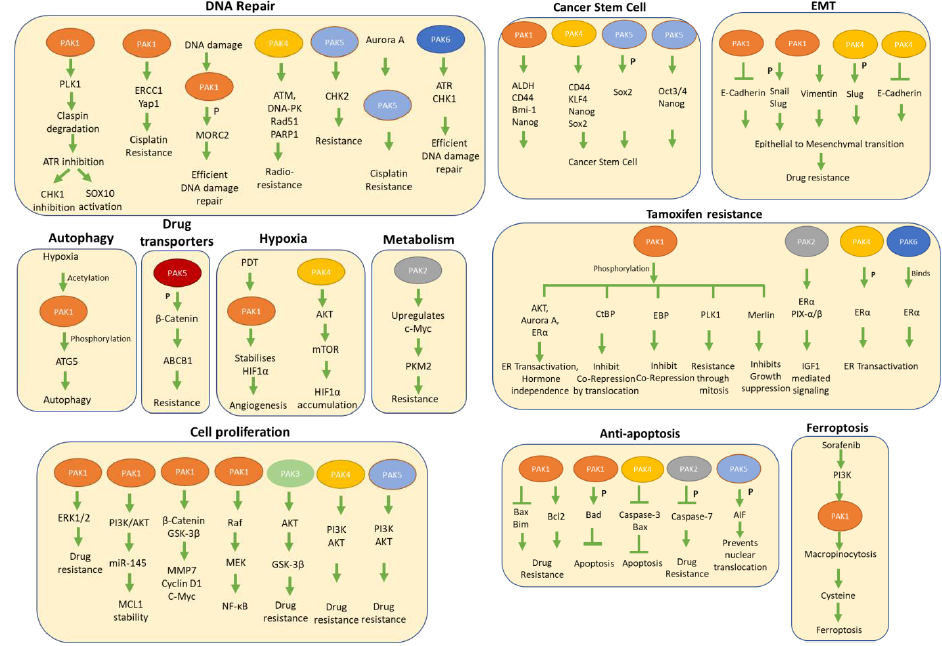
Figure 3. Diagram showing different pathways activated by PAK in regulating drug resistance.